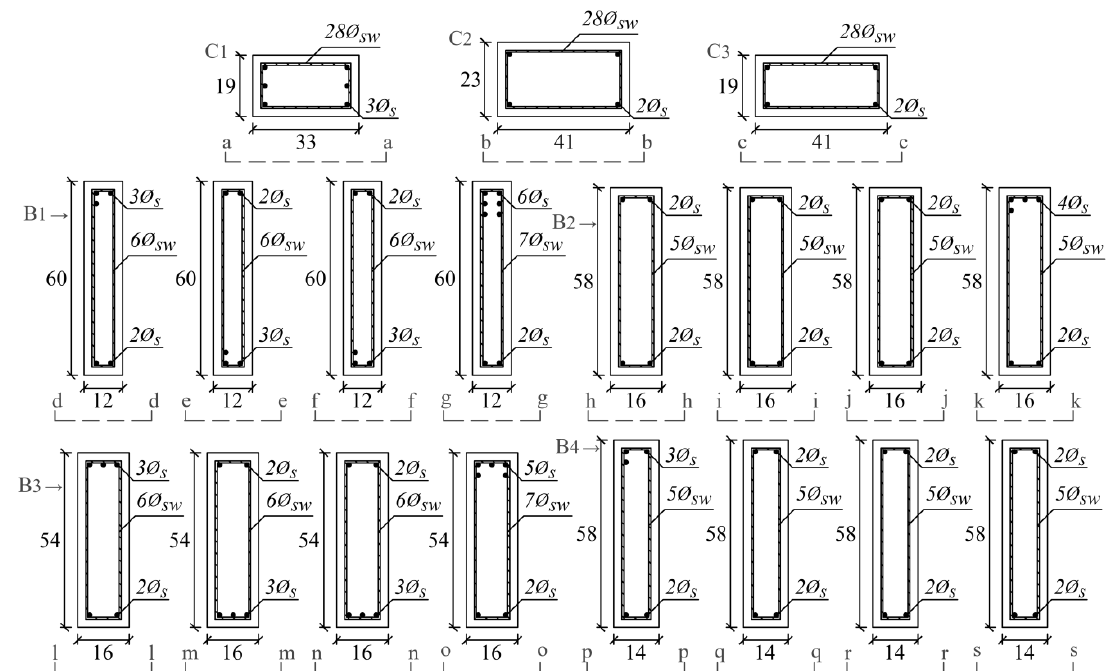
Figure 10. Detailing the optimal sections (dimensions in cm) - Example II: case I.